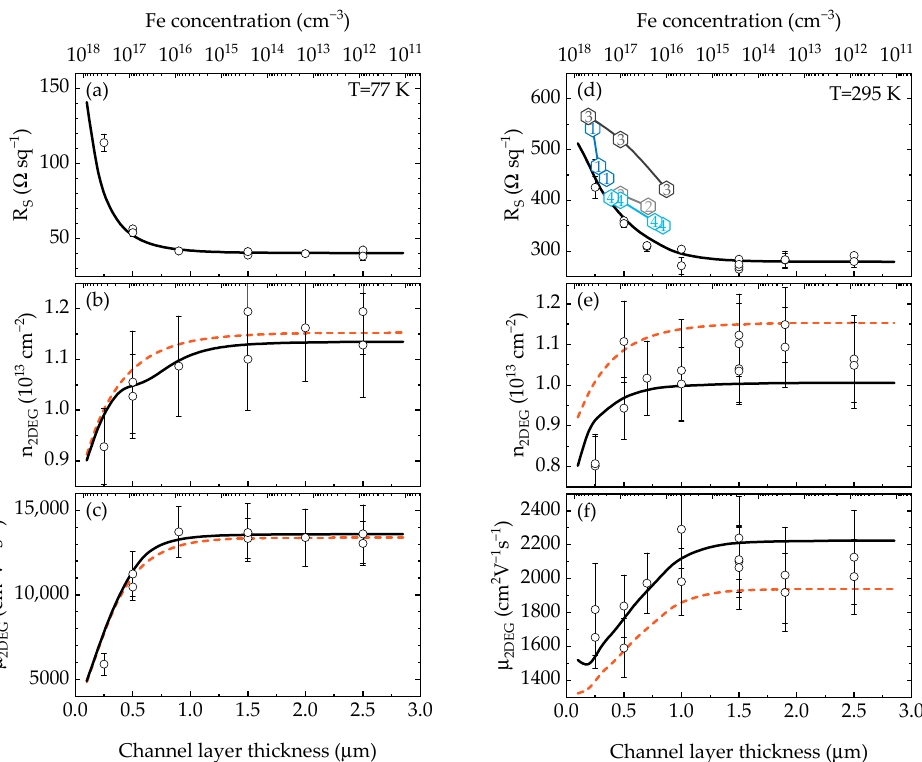
Figure 2. The sheet resistance, 2DEG concentration and mobility versus the GaN channel thickness at 77 K and RT (( a – f ), respectively). The top X axis shows the Fe impurity concentration at AlN/GaN interface. The solid lines in ( b , c , e , f ) correspond to the calculated Hall concentration and mobility, while the dashed lines correspond to the calculated drift concentration and mobility. Open circles are the experimental data from this work. Hexagons with numbers in ( d ) show R S versus Fe concentration from the references: 1—[8]; 2, 3—[9]; 4—[31].